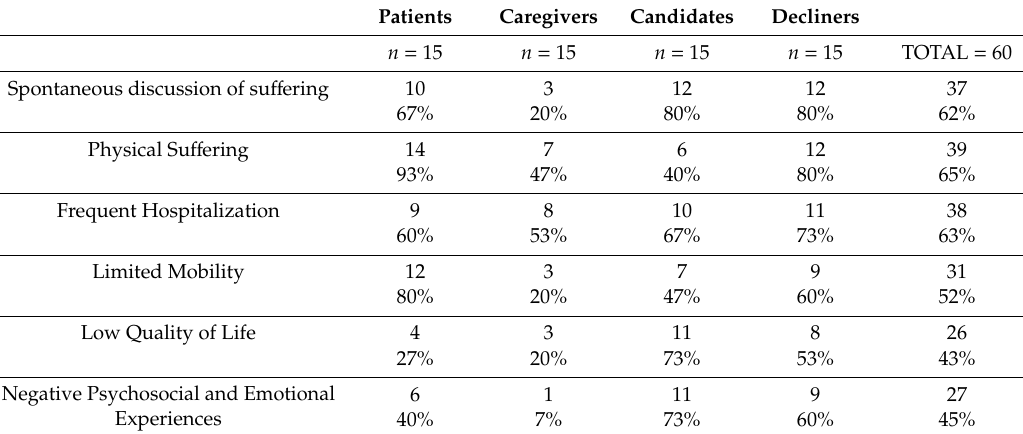
Table 2. Variables of su ff ering and healing pre-implant.